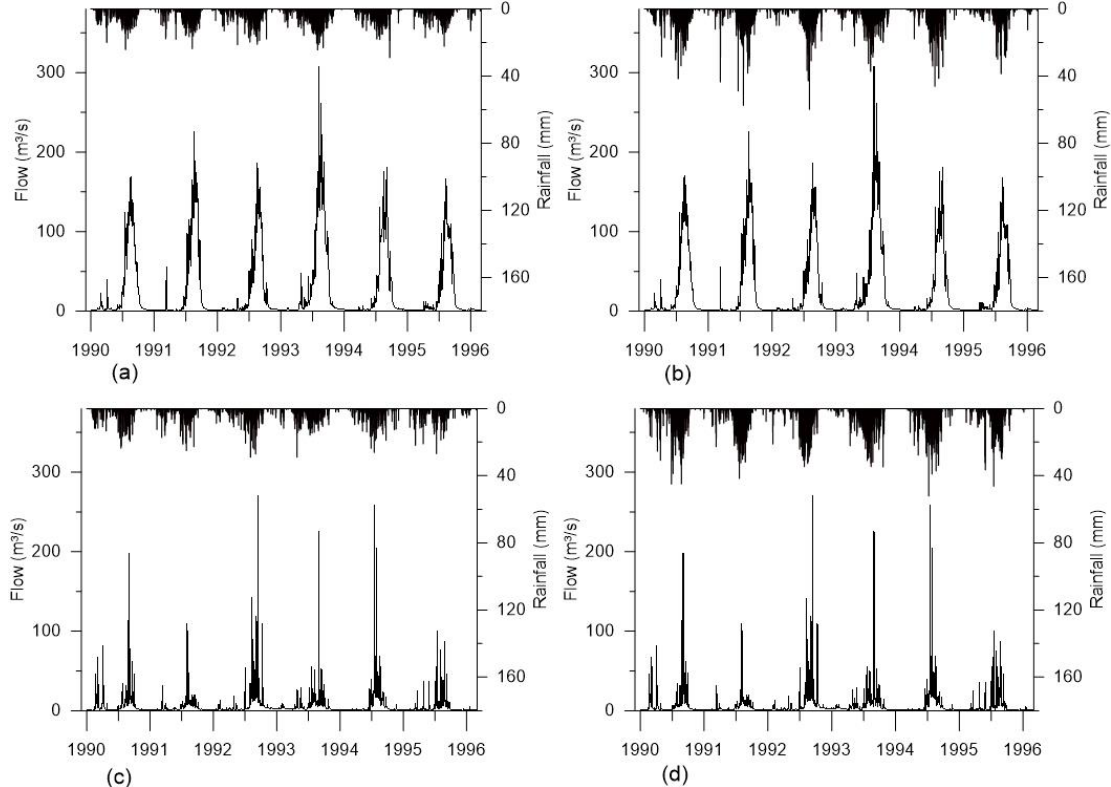
Figure 7. Time series of daily observed flow and areal rainfall. ( a ) Observed flow vs. rainfall from conventional weather at Melka Kunture, ( b ) observed flow vs. rainfall from CFSR weather at Melka Kunture, ( c ) observed flow vs. rainfall from conventional weather at Keleta, and ( d ) observed flow vs. rainfall from CFSR weather at Keleta.